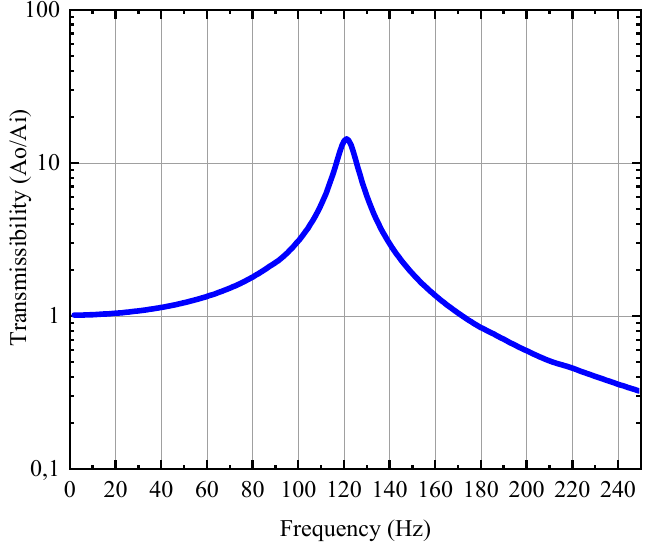
Figure 11. Vertical transmissibility (output acceleration (A o ) at the center of the cold-plate surface divided by input acceleration applied at the baseplate).